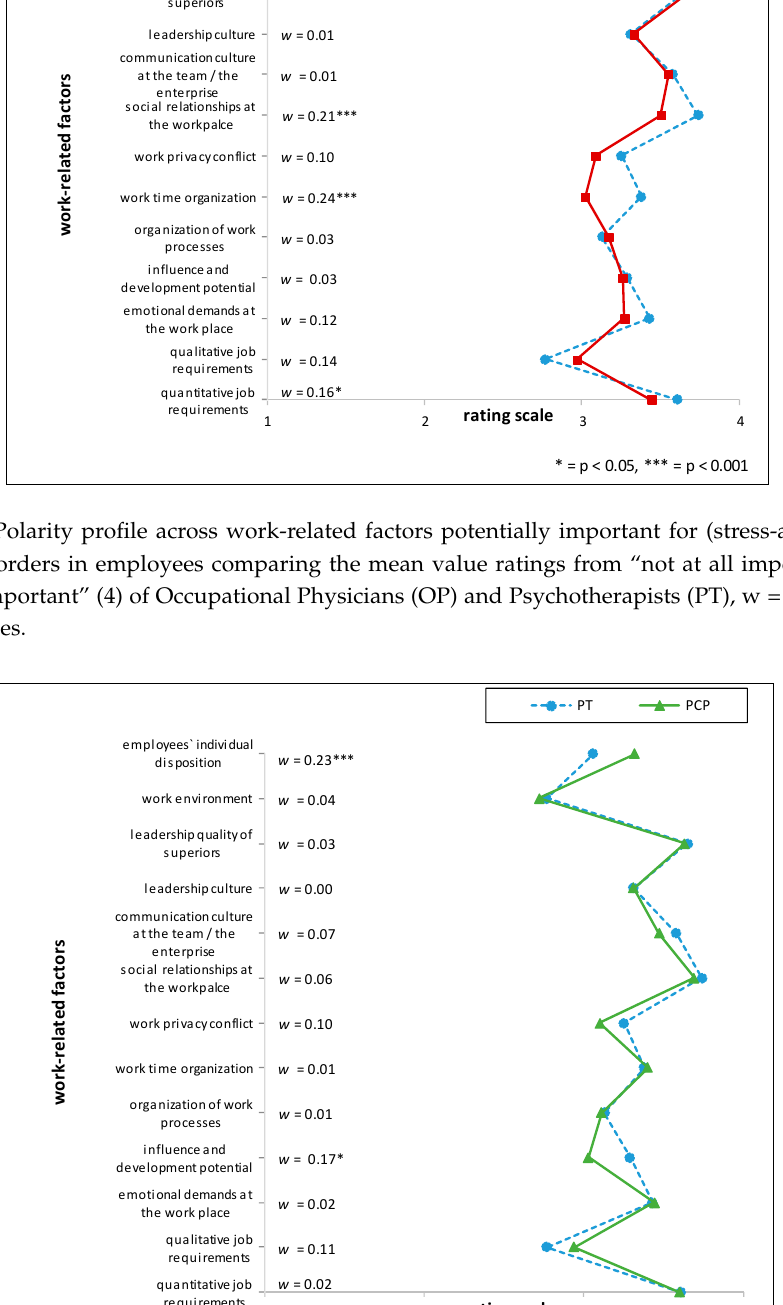
important” (4) of Occupational Physicians (OP) and Primary Care Physicians (PCP), w = effect size of